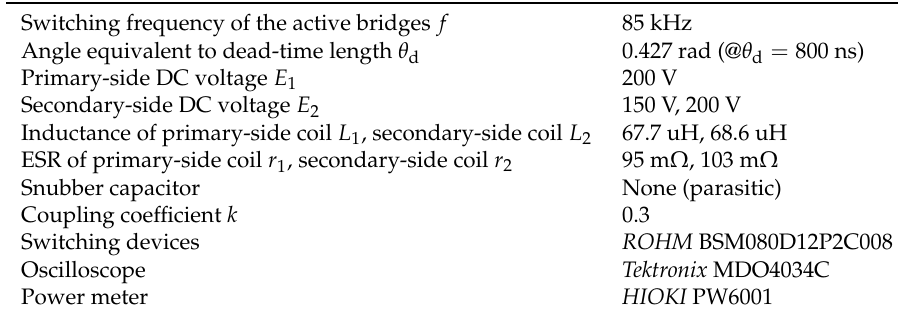
Table 2. Circuit parameters in the experiments.